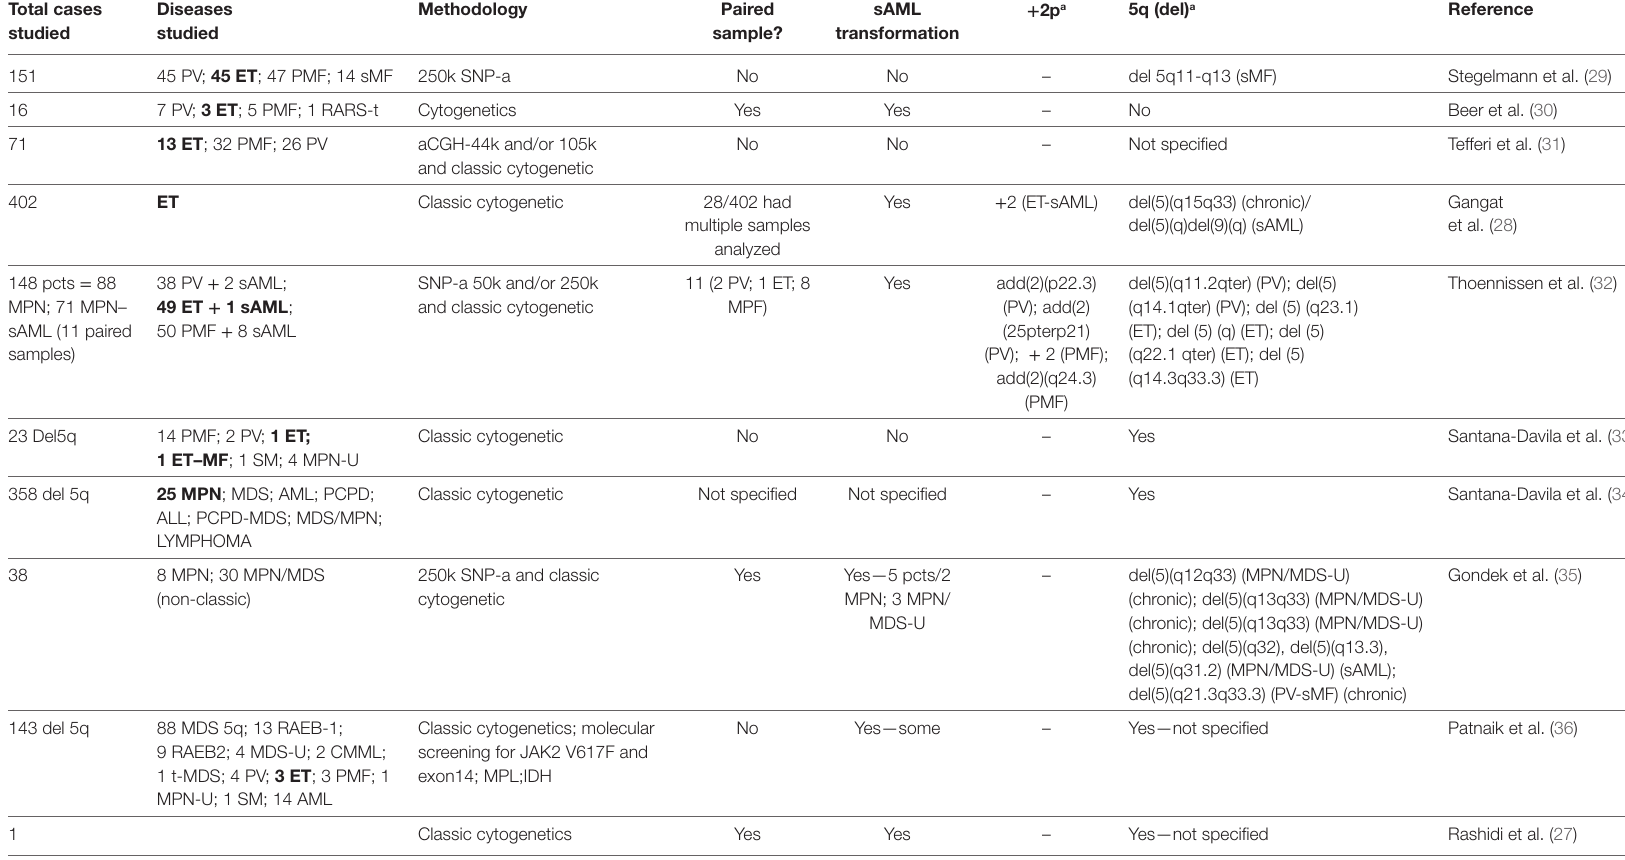
Table 3 | Comparative studies showing previous reports in + 2p and del5q in myeloproliferative and myelodysplasia